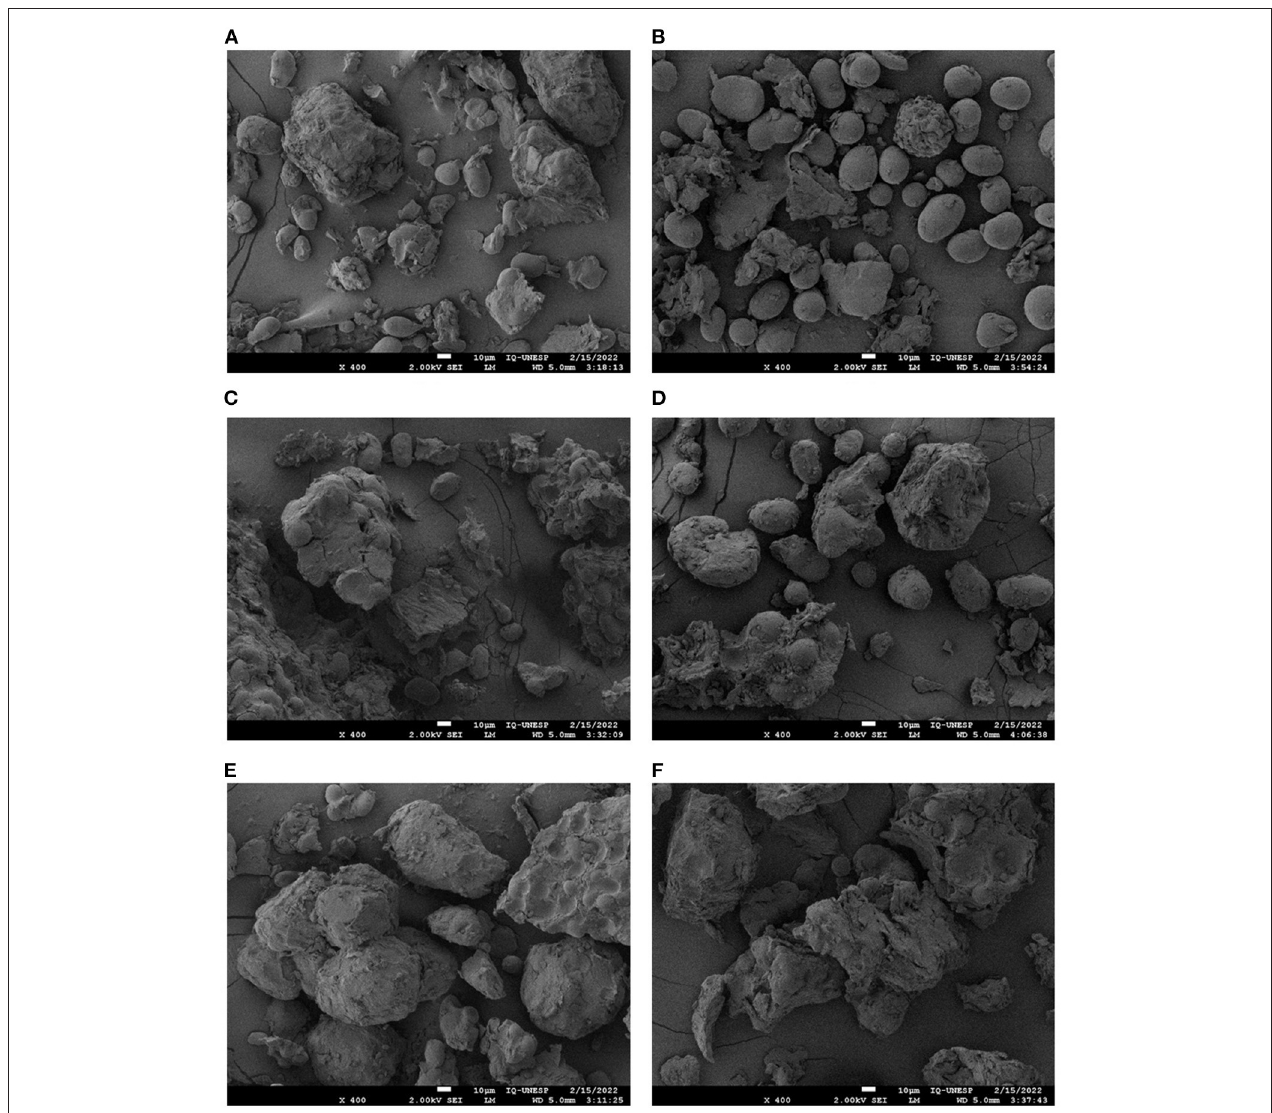
FIGURE 1 | SEM micrographs (400 × -magnification) of bean flours produced from mung bean (A,C,E) and red kidney bean (B,D,F) untreated (control) (A,B) ; soaked (C,D) ; soaked + boiled (E,F) .